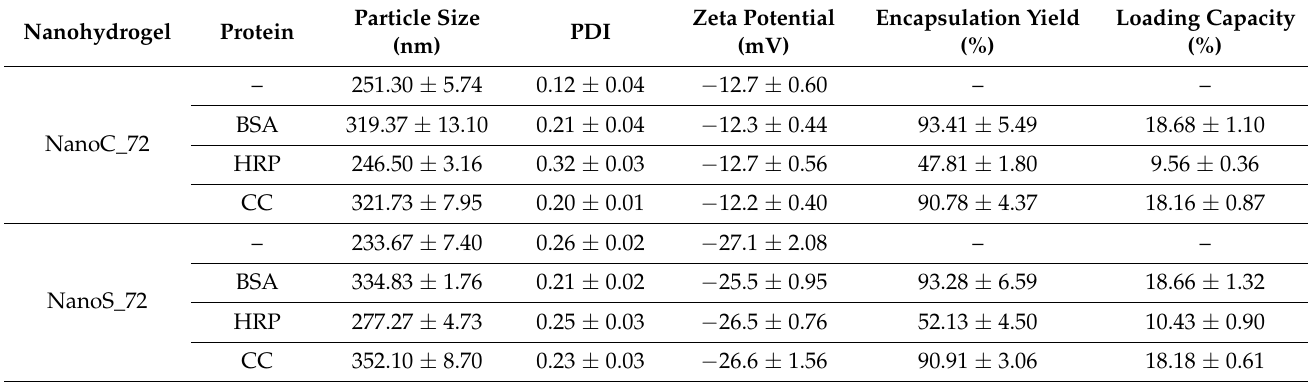
Table 5. Characterization of protein loaded NanoC and